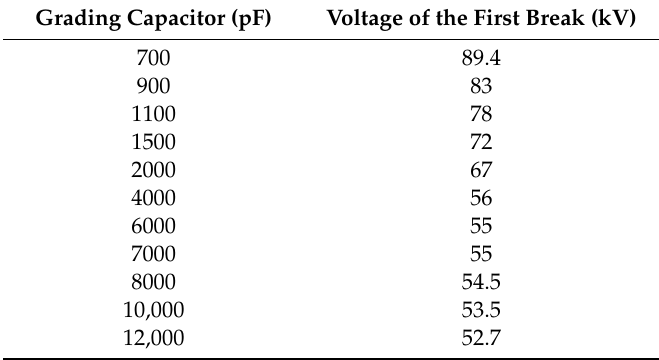
Table 4. Voltage of the first break at different grading capacitor values.